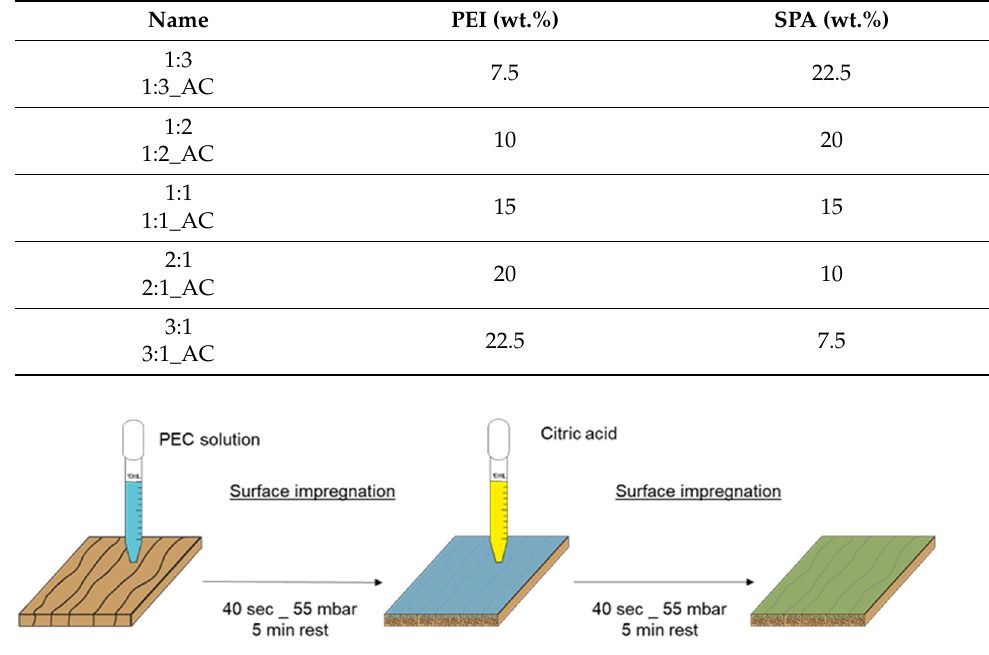
Figure 2. Schematic representation of PEC deposition